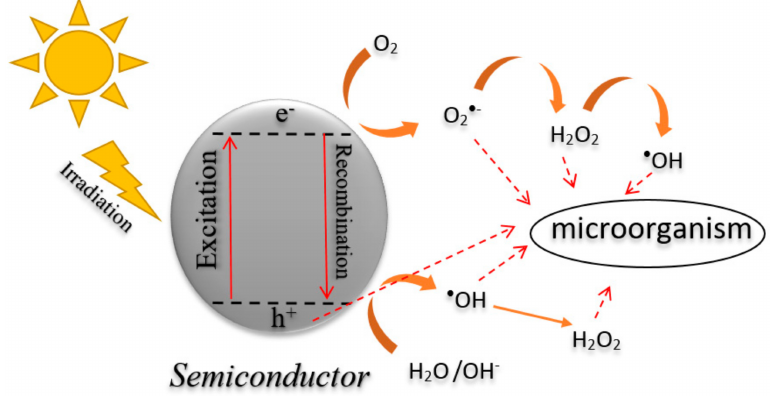
Figure 1. Schematic diagram for the photocatalytic mechanism of a